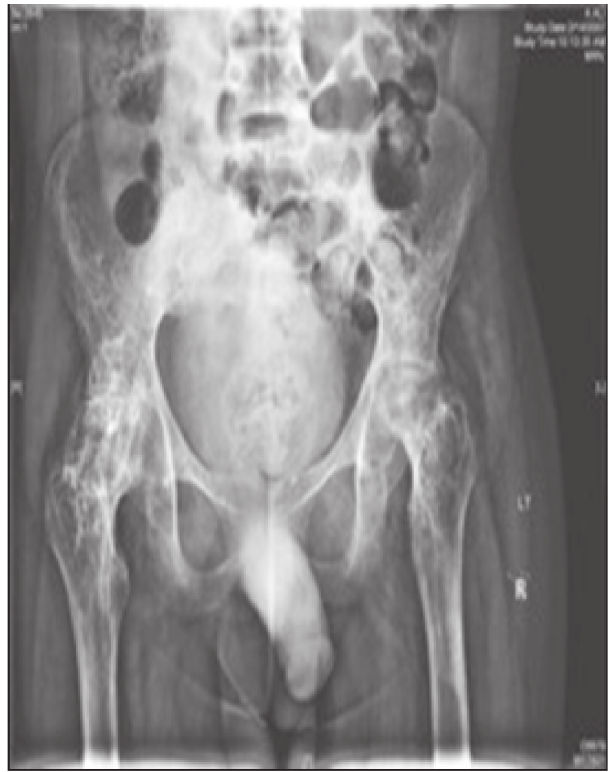
Figure 1. AP Hips x-rays showed severe avascular necrosis and ankylosis.